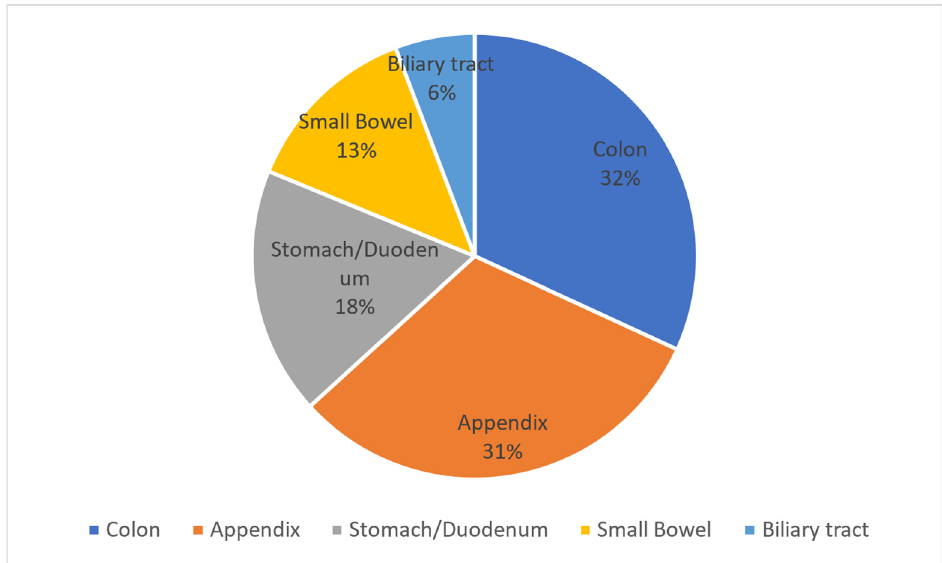
Figure 1. This cake diagram illustrates the percentage of sites of infections causing secondary peritonitis according to the viscus of origin.